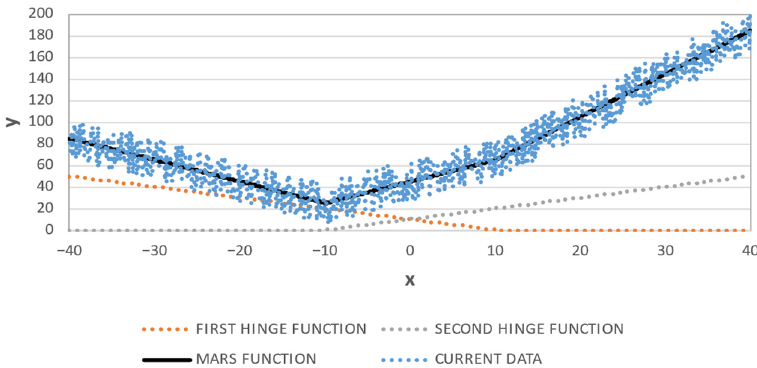
Figure 1. Example of a MARS model to approximate a non-linear real